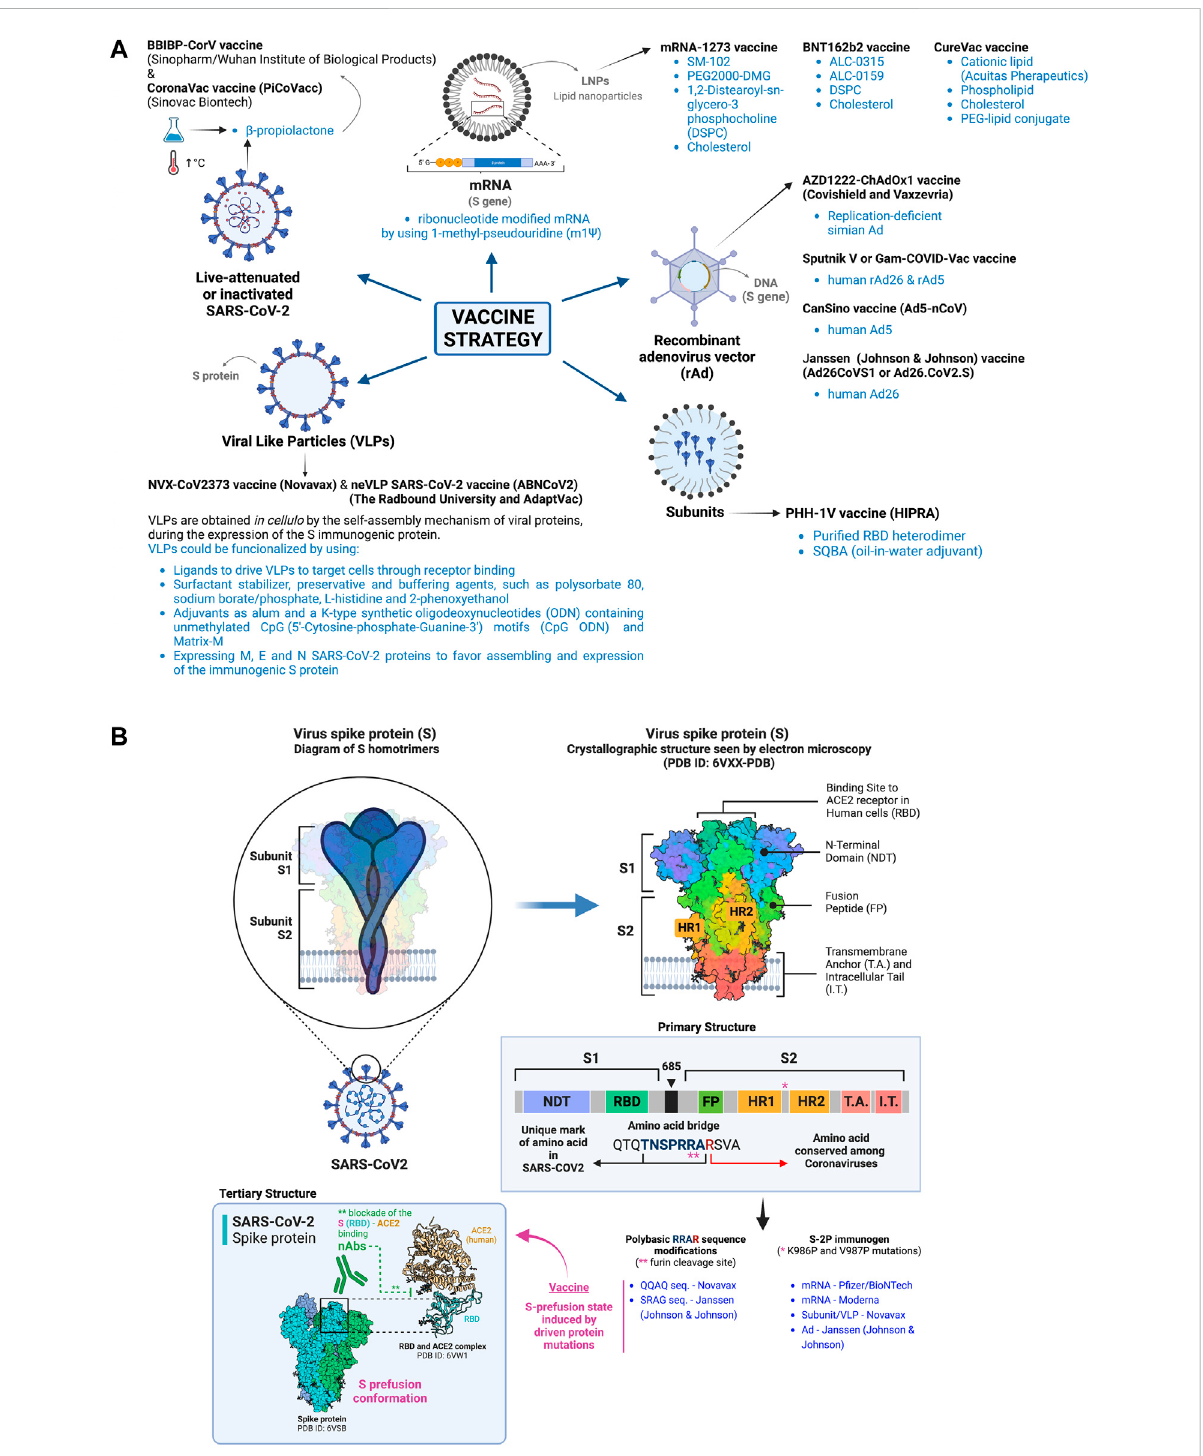
FIGURE 3 Nano-based COVID-19 vaccines. (A) The scheme summarizes the different nano-based strategies used for immunization against SARS-CoV- 2 infection and severe COVID-19 based or different nanomaterials and reagents to deliver the modi fi ed viral genome (coding for the immunogen S protein) and recombinant immunogen S protein or its subunits, such as the LNP-mRNA vaccines, the rAd vectors containing the DNA S gene, chemically inactivated SARS-CoV-2 viral particles, VLPs bearing recombinant S protein, and recombinant subunit vaccines (i.e., adapted full- length S protein or fragments as the RBD region) in emulsion with nanoreagents. All nanomaterials and nanotechnology used for vaccine